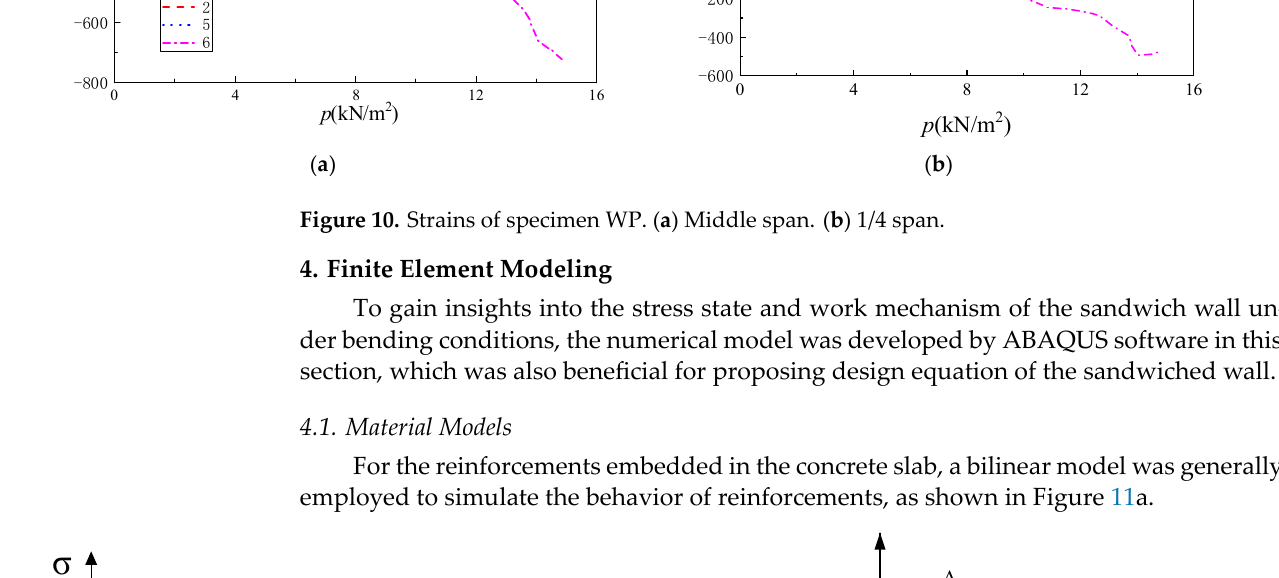
Figure 10. Strains of specimen WP. ( a ) Middle span. ( b ) 1/4 span.